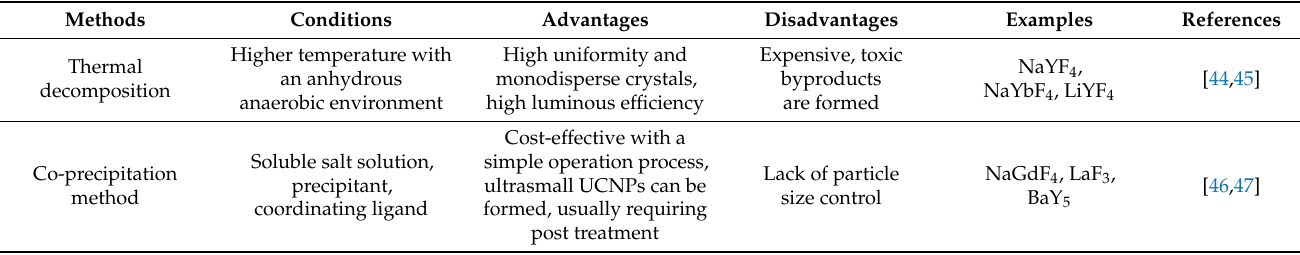
Table 1. Methods for synthesis of